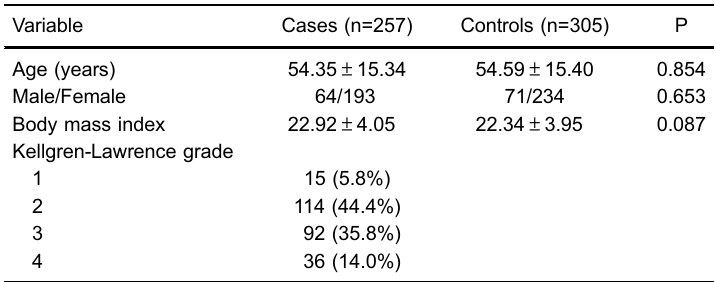
Table 1. Patient demographics and risk factors for osteoarthritis.